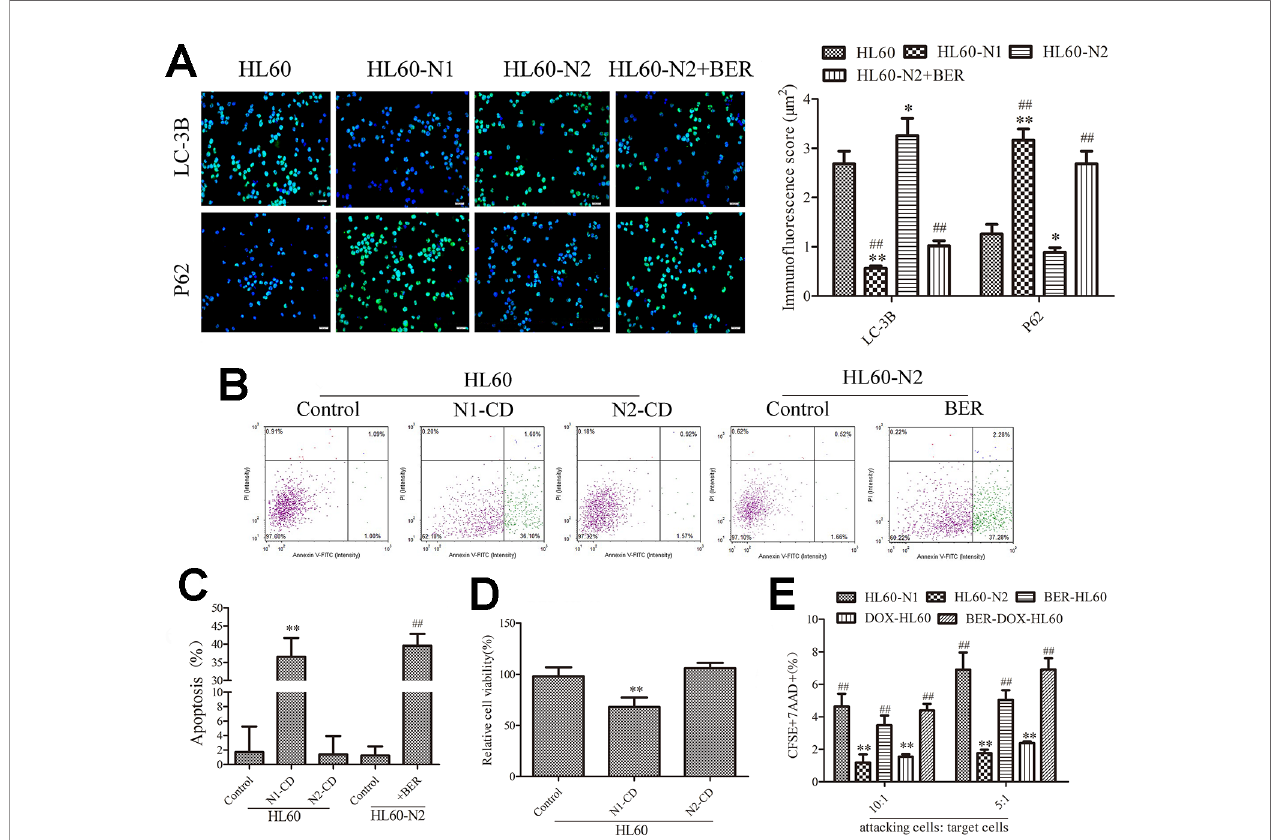
FIGURE 2 | N1-like and N2-like neutrophils had different effects on HL-60 cells. (A) Cell autophagy as indicated by LC-3B and P62 staining (n = 5, 40×). (B , C) and (C) Cell apoptosis detected by the Annexin V-FITC apoptosis kit (n = 5). (D) HL-60 cell viability detected by 3-(4,5-dimethylthiazol-2-yl)-2,5-diphenyltetrazolium bromide (MTT) assay (n = 5). (E) Cytolytic activity (n = 5). The data present mean ± SD, the experiments were repeated three times, and statistical signi fi cance was determined by a t-test. (A , C , D) *P < 0.05, **P < 0.01 vs . HL60; ## P < 0.01 vs . HL60-N2. (E) *P < 0.05, **P < 0.01 vs . HL60-N1; ## P < 0.01 vs . HL60-N2. DOX, doxorubicin; BER,